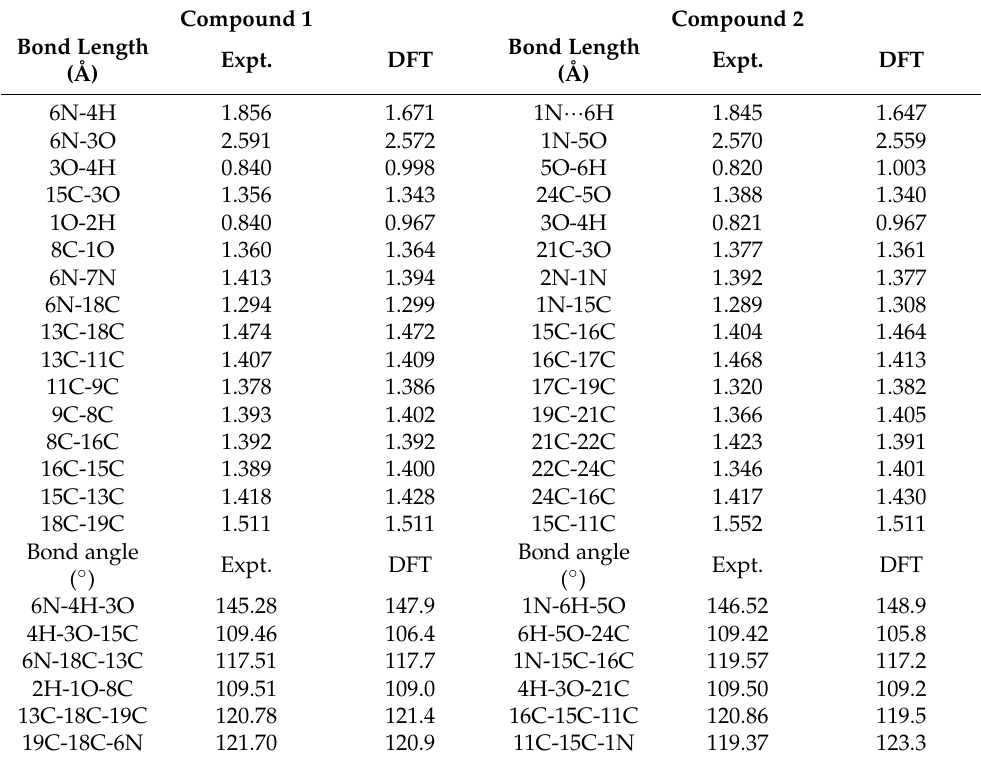
Figure 4. DFT computed the molecular structures of ( a ) compound 1 and ( b ) compound 2 . Atom-by-atom superimposition of ( c ) compound 1 and ( d ) compound 2 calculated over the X-ray structure. Table 3. Selected structural parameters, including bond length (Å) and bond angle ( ◦ ) by X-ray and theoretical calculations for compounds 1 and 2 . Compound 1 Compound